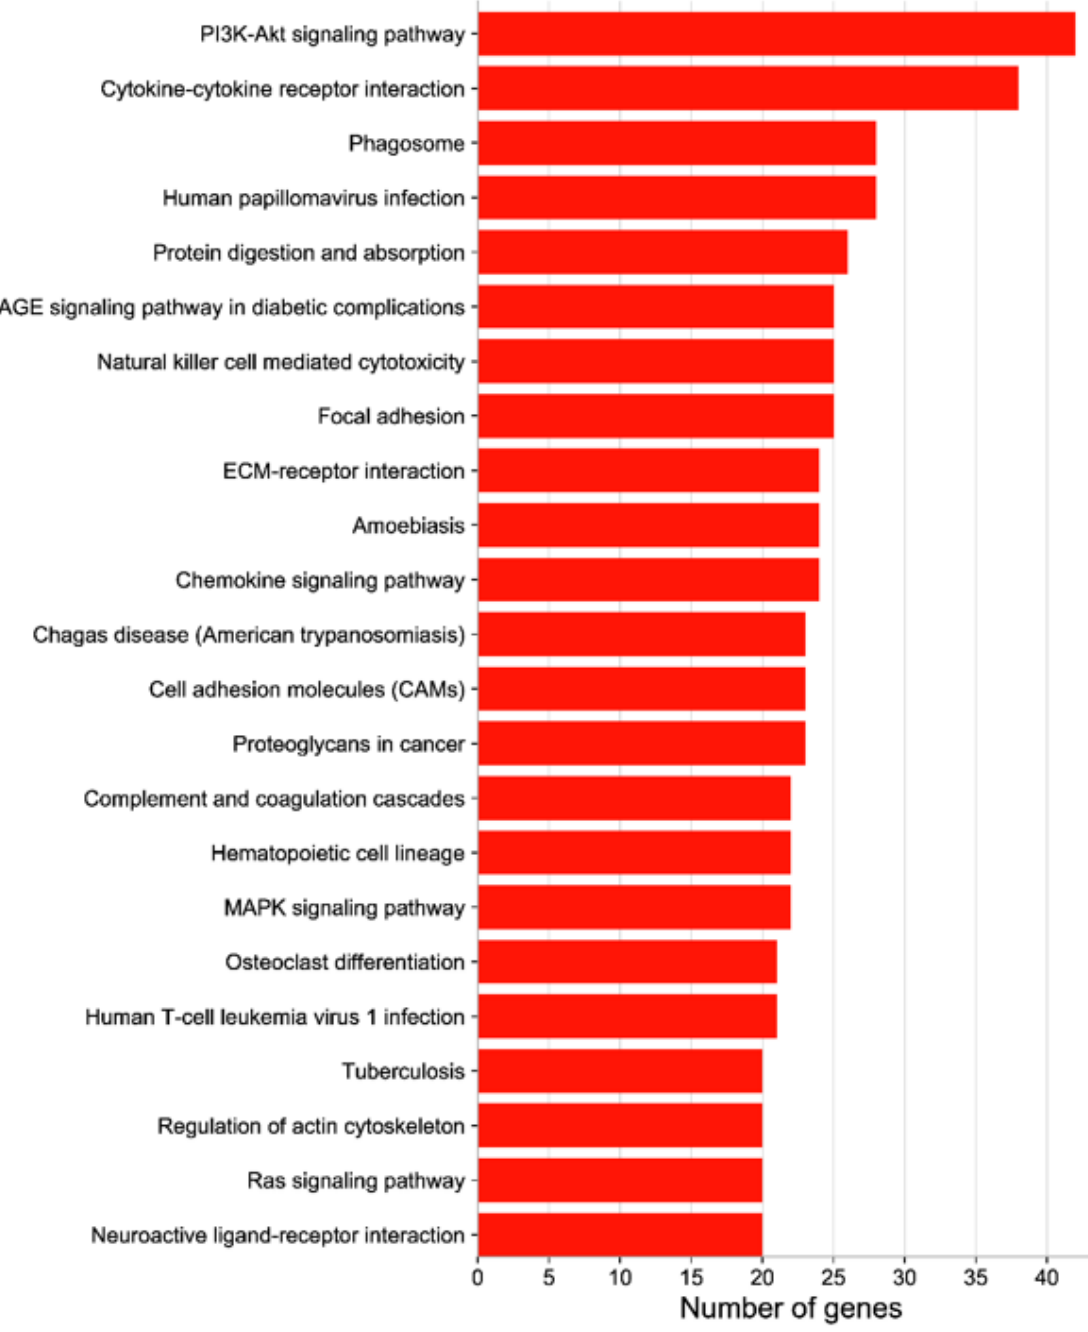
Figure 4. KEGG enrichment analysis of DEGs between the treatment and control groups. The vertical coordinate indicates the KEGG pathway, and the horizontal coordinate indicates the number of DEGs enriched to this pathway.